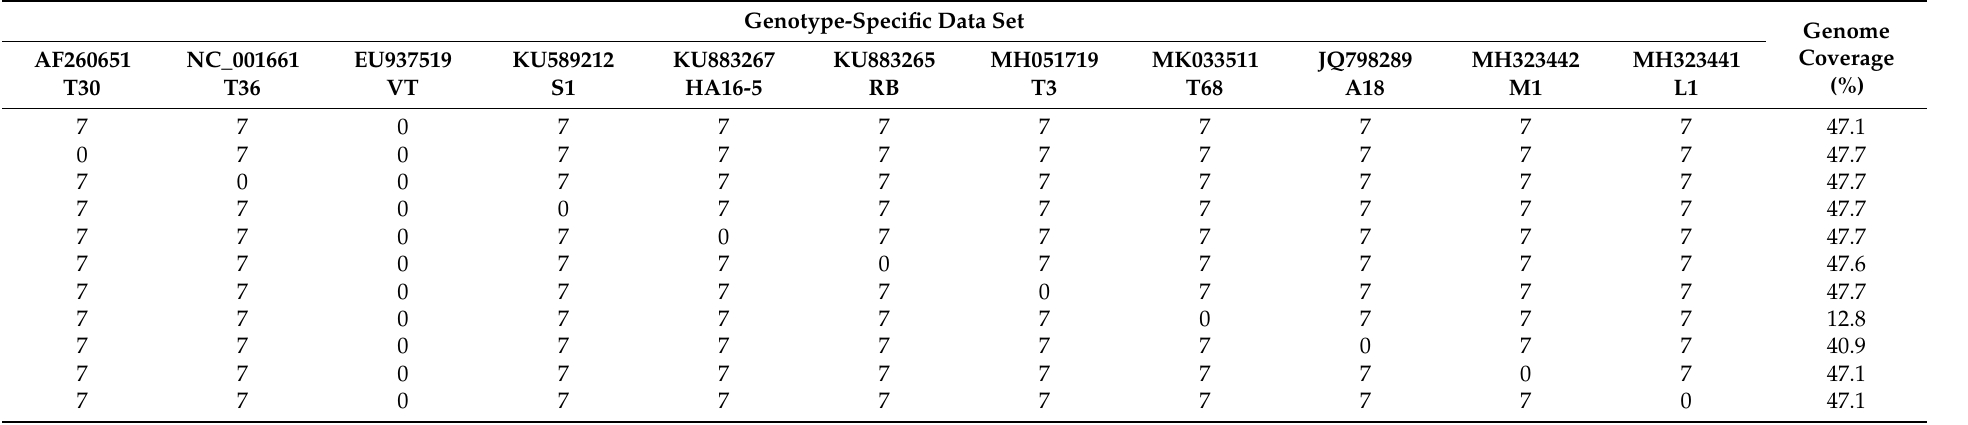
Table 2. Non-target genome coverage (%) of genotype VT (EU937519) after read mapping all the other ten genotype specific data sets and then subtracting each of the genotype-specific data sets to identify the major contributor to the VT non-target read mapping. A “0” represents no data were added to the pool of reads used for the specific read mapping event, and a “7” represents that the 7th largest data set (one million read pairs) was added to the pool of reads used for the specific read mapping